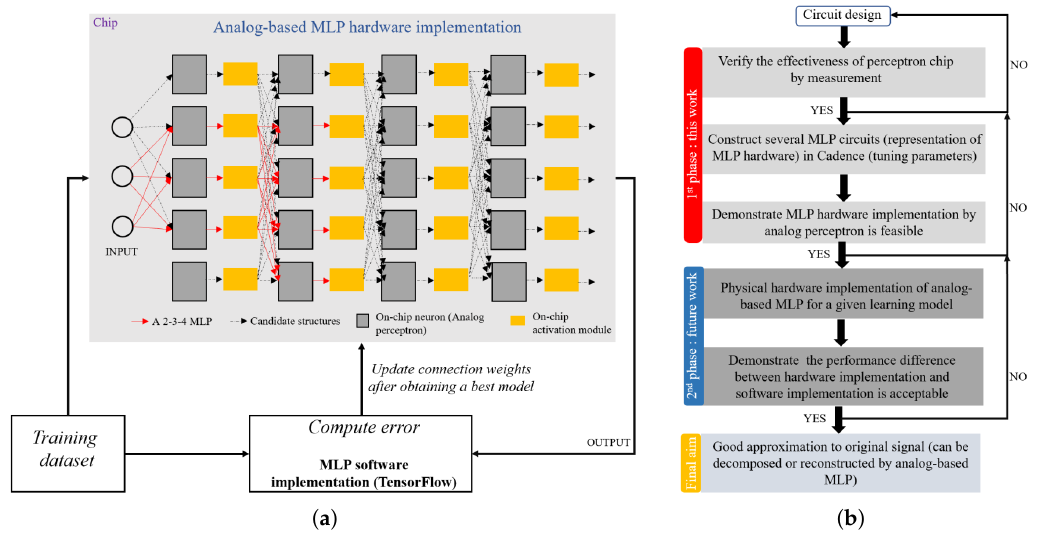
Figure 2. ( a ) Configuration of our proposed analog-based MLP and learning algorithm. ( b ) Contributions in this